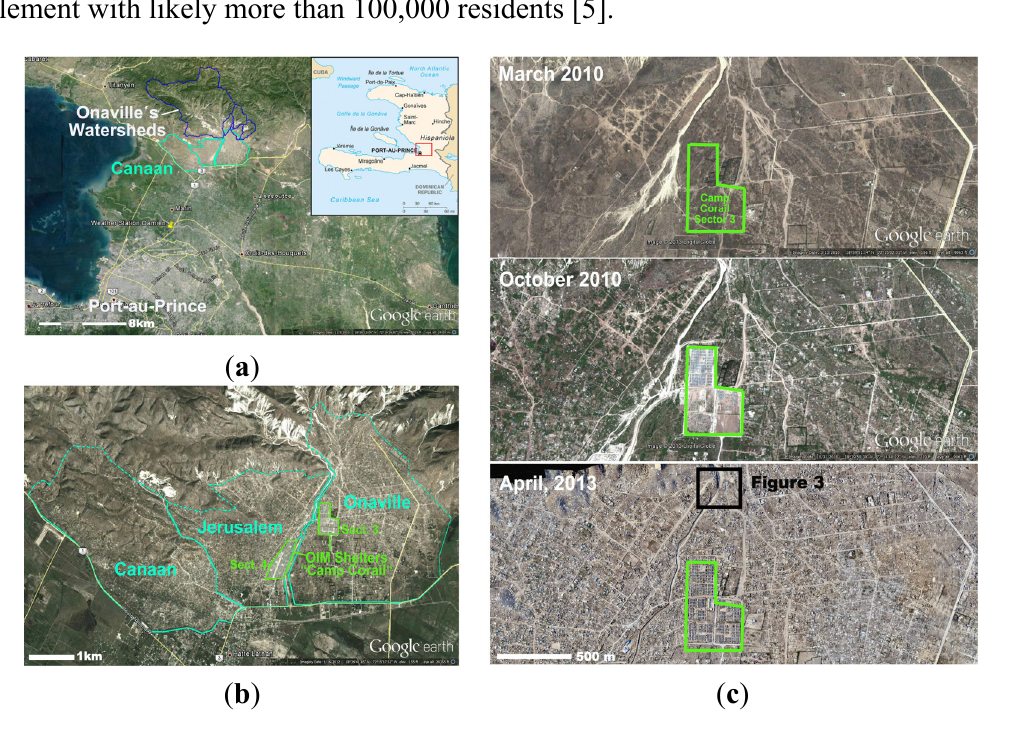
Figure 1. ( a ) Location of Canaan in Haiti; ( b ) Location of Camp Corail and Onaville in Canaan; ( c ) settlement process of Onaville between 2010 and 2013